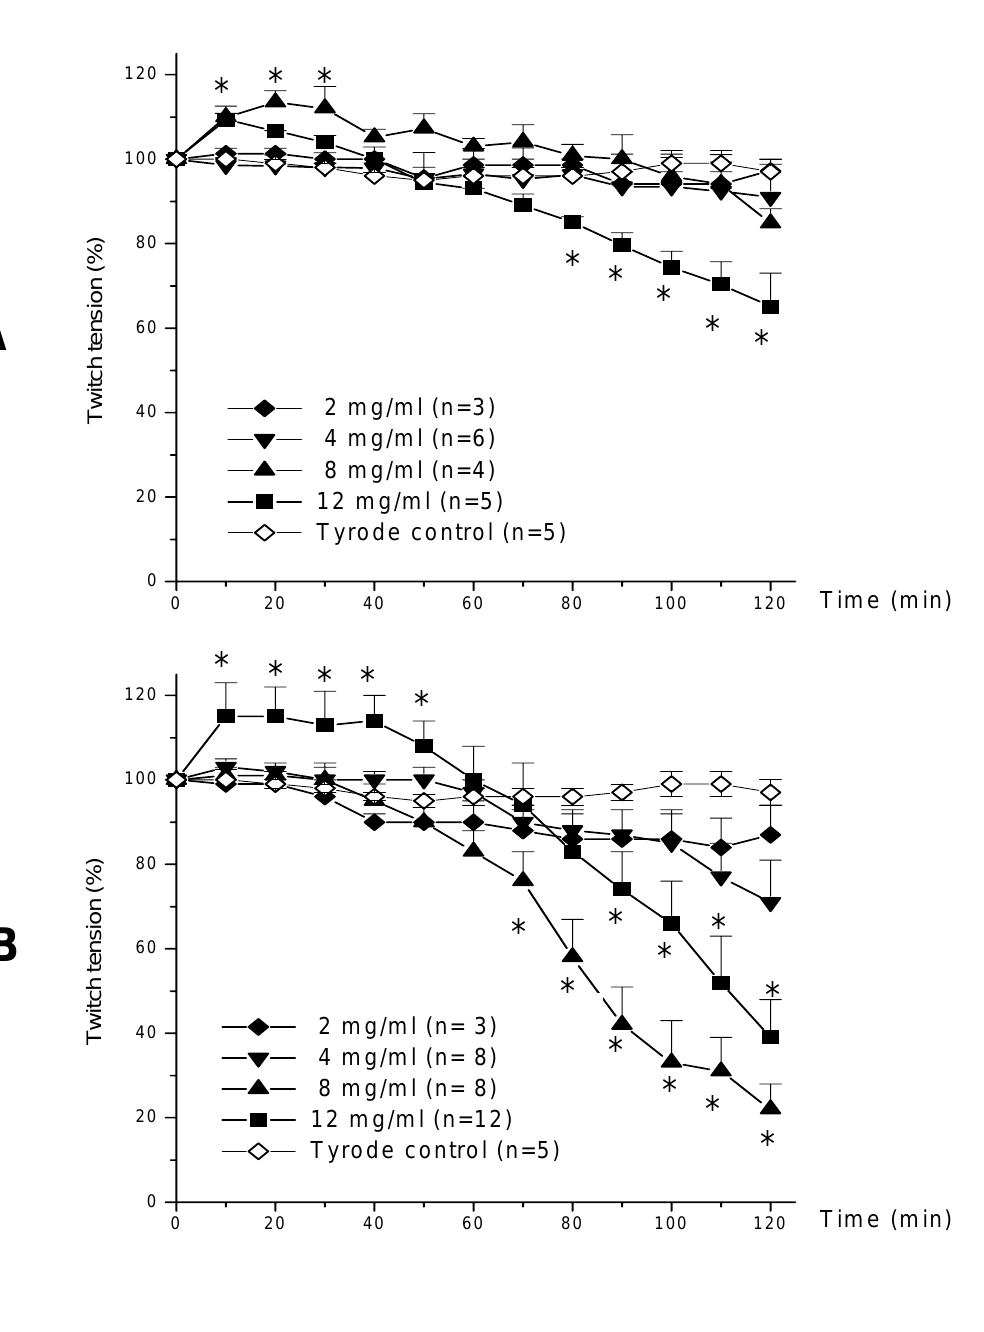
Figure 3: Neuromuscular activity of aqueous (A) and hydroalcoholic (B) extracts from the leaves of C. sylvestris in mouse isolated phrenic nerve-diaphragm preparations. Each point represents the mean ± S.E.M. of the number of experiments indicated in parentheses. *p<0.05 compared to the Tyrode